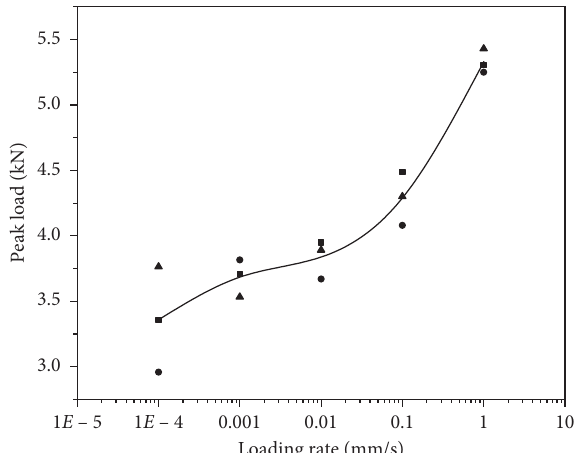
Figure 3: Influence of different loading rates on peak load.